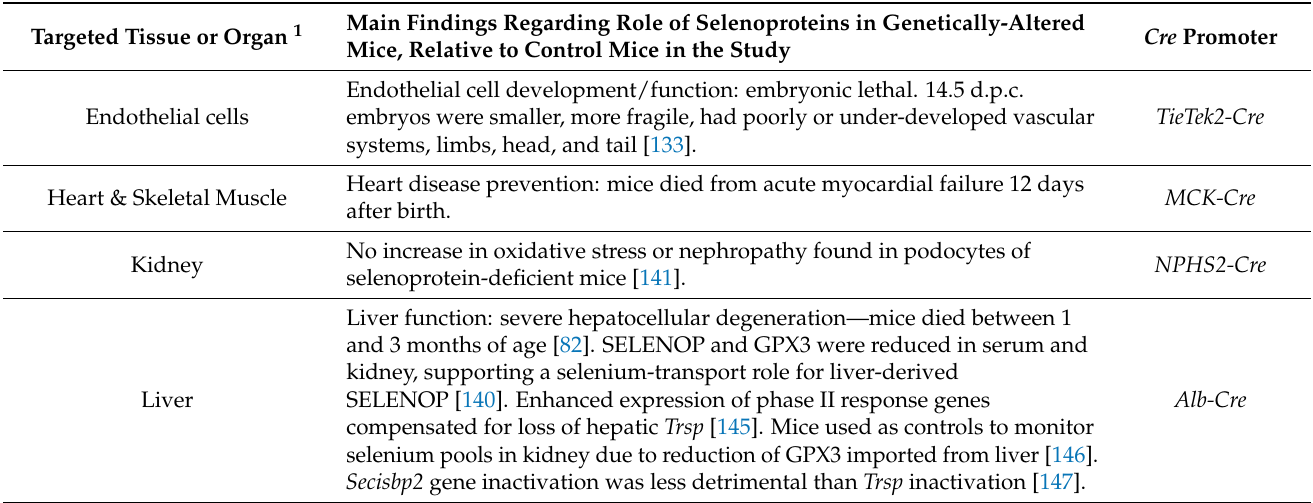
Table 3. Trsp conditional knockout mouse